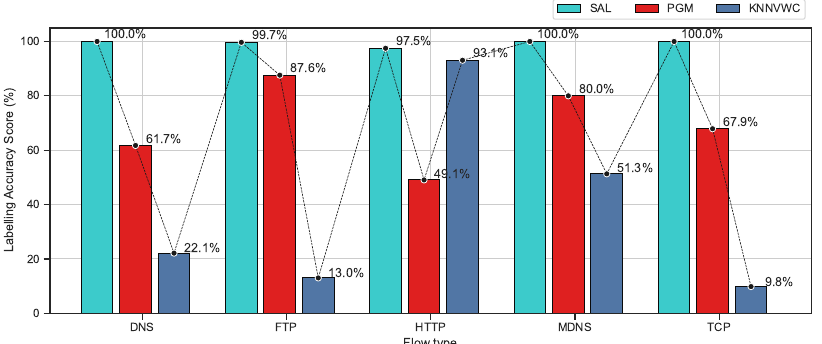
Figure 10. Comparison of labeling processes based on recall metrics on the ISCX